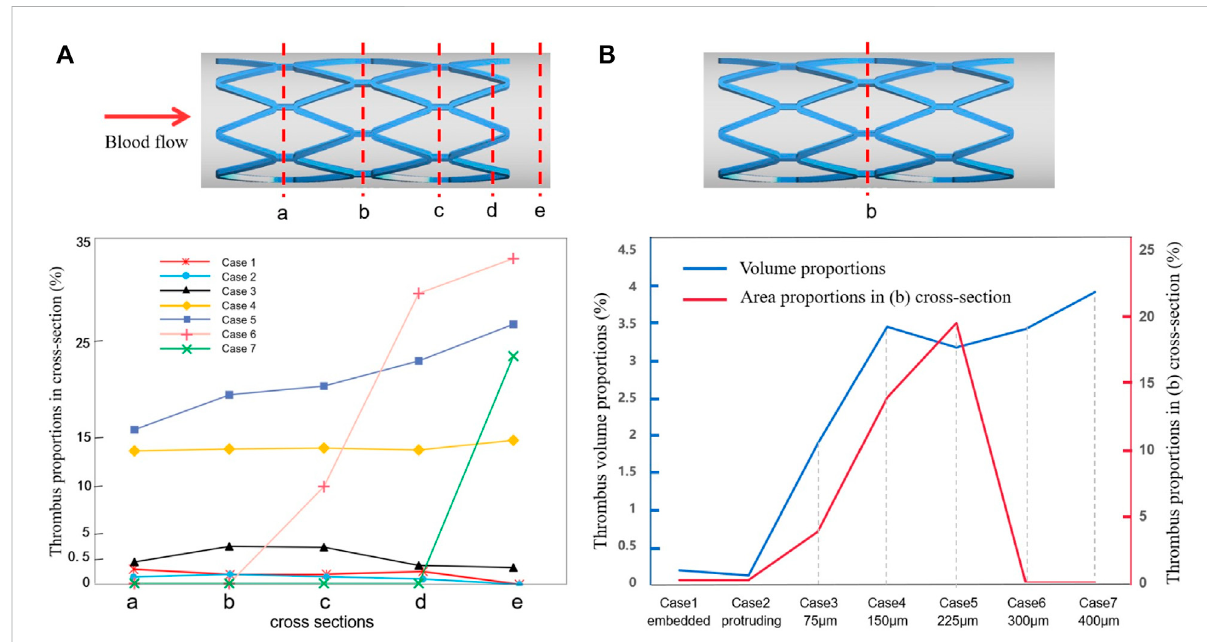
FIGURE 7 Thrombus accumulation amount at the end of simulation: (A) thrombus proportions in fi ve cross-sections (a – e) of all cases; (B) thrombus area proportions in the mid-stent cross-section (b) and thrombus volume proportions in the fl uid domain.